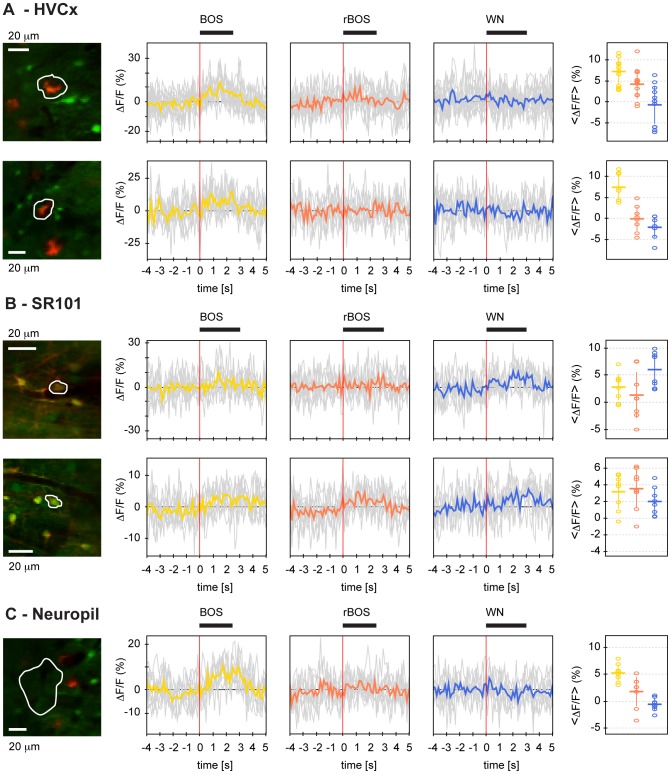
Auditory responses in different identified HVC cells and neuropil.
A–C Left: Mean images of acquired movie stacks with the ROIs encircled in white. Middle: Marked on top are auditory stimuli (black horizontal bars); below are the individual ΔF/F responses (gray) and the mean responses (color). Right: Baseline-subtracted ΔF/F responses averaged over stimulus durations (WN shown in blue, rBOS in red, and BOS in yellow). Legend as in Fig. 3 E. A Response panels of two HVCX neurons, with the neuron on top responding more to BOS (Z-score  = 0.98) than to rBOS (Z-score  = 0.58); the WN stimulus slightly suppresses OGB-1 fluorescence (Z-score  = −0.25). The neuron is BOS-selective: d′ BOS-WN  = 1.42, d′ BOS-rBOS  = 0.40, d′ WN-rBOS  = −1.10. The HVCX neuron below shows even stronger BOS selectivity, d′ BOS-rBOS  = 3.33 and d′ BOS-WN  = 4.61. This neuron is neutral in its preference for WN vs. rBOS (d′ = 0.17). B Auditory responses in two cells labeled with SR101, i.e. presumptive astrocytes. The first cell responds strongest to WN (Z-score  = 1.86), but also to BOS (Z-score  = 1.09), whereas rBOS elicits only a weak response (Z-score  = 0.30). The second cell responds about equally to all auditory stimuli with Z-scores in the range of 1.2–1.5. C Neuropil ROI showing large response to BOS (Z-scores for BOS  = 3.19, for rBOS  = 0.61, and for WN  = −0.45).